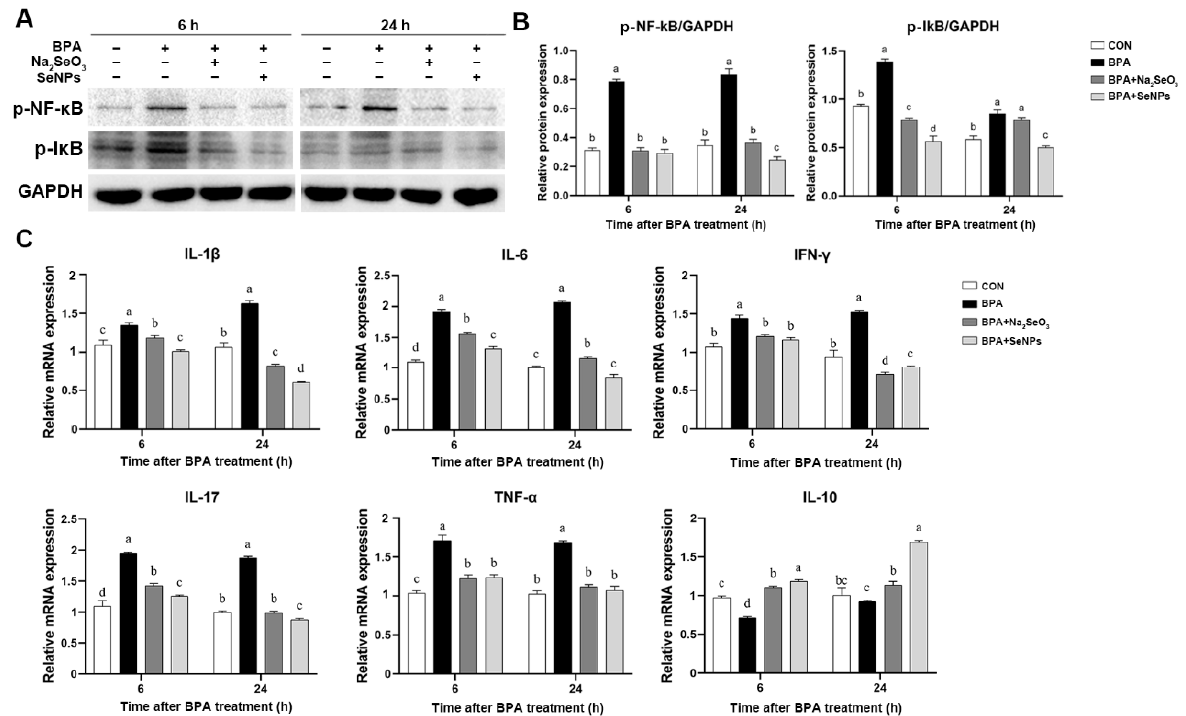
Figure 5. Effect of Na 2 SeO 3 and SeNPs treatment on the inflammatory response of IPEC-J2 cells after BPA exposure. Representative panels showing expression of p-NF- κ B and p-I κ B by Western blotting at 6 and 24 h after BPA exposure ( A ). Expression of GAPDH was measured as an internal control. Results are presented as the ratio of p-NF- κ B and p-I κ B band intensity to that of GAPDH ( B ). The relative expression of mRNAs for the IL-1 β , IL-6, IFN- γ , IL-17, TNF- α , and IL-10 genes was analyzed by quantitative real-time PCR ( C ). Data are presented as the means ± SEM of three independent experiments. a,b,c,d Mean values within a row with different superscript letters were significantly different ( p < 0.05).